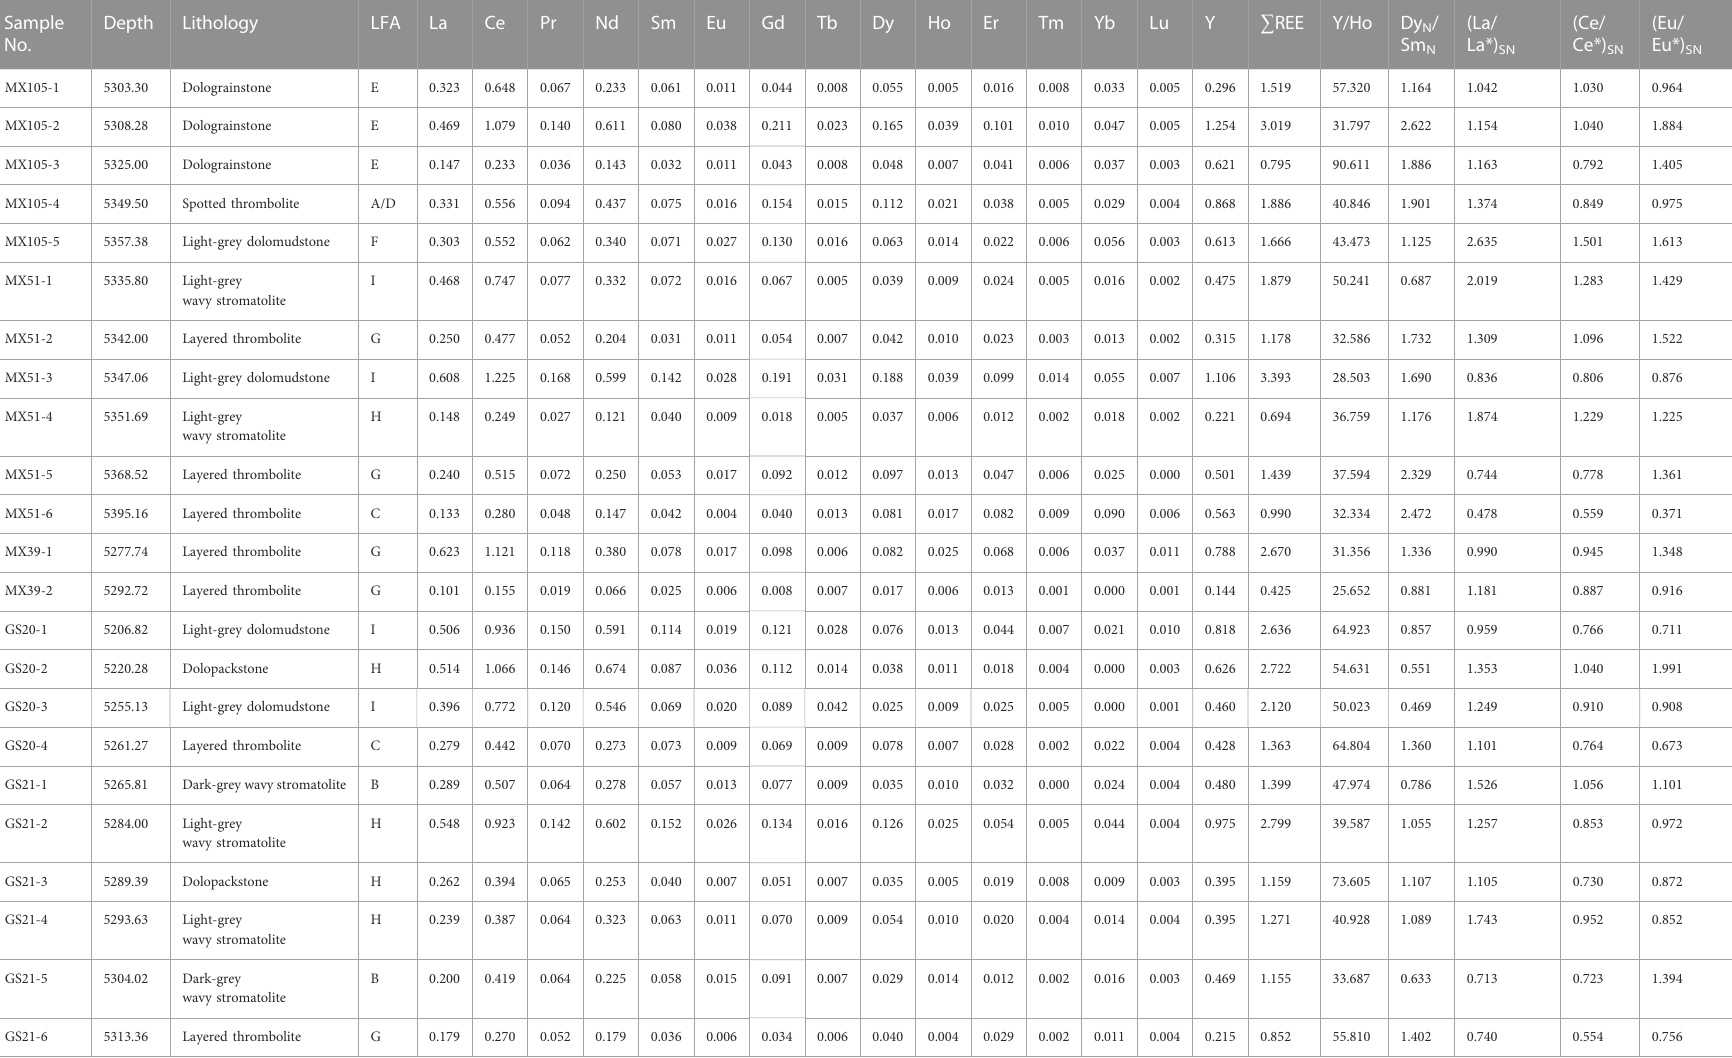
TABLE 2 REE+Y concentrations, ratios and anomalies of the studied samples (ppm) (LFA, llithofacies association; SN, shale normalized). Sample